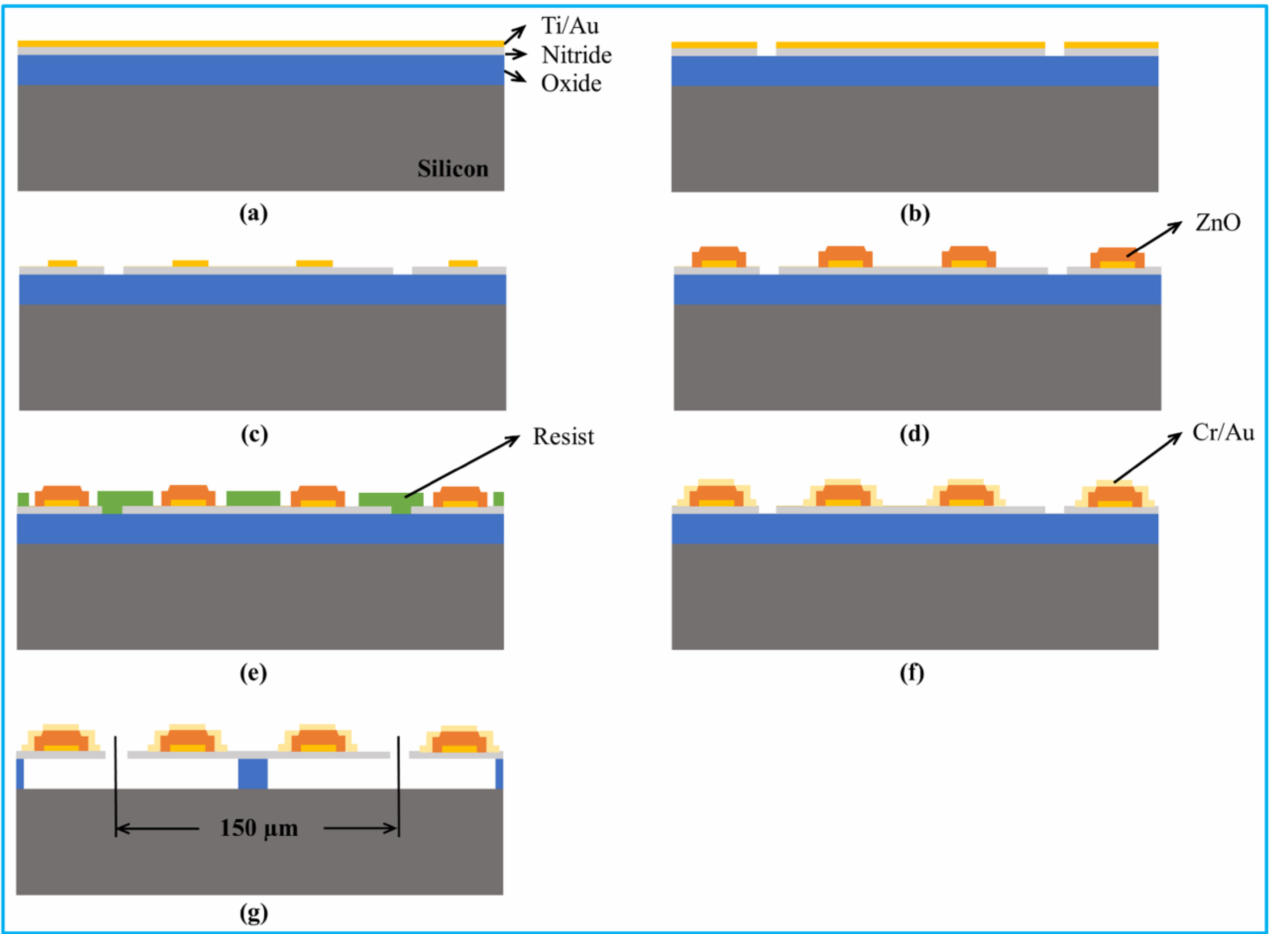
Figure 5. ( a – g ) A typical fabrication processes of PMUT by the sacrificial releasing method. Reprinted from Ref. [20] with